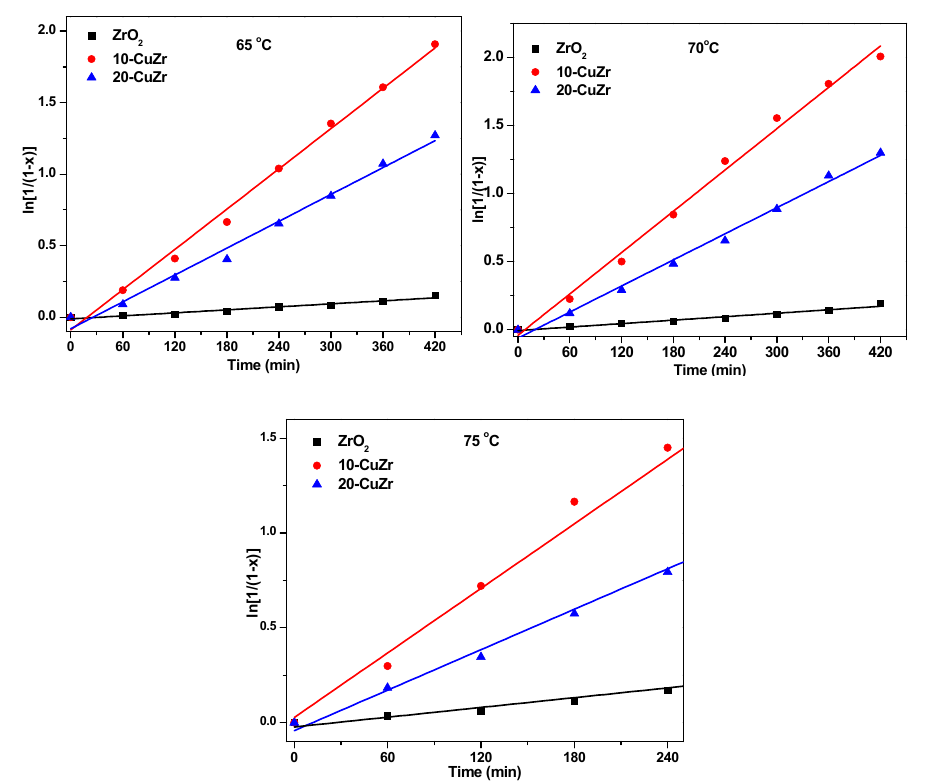
Figure 9. Plot of ln[1/(1 − x )] as a function of the reaction time for all catalysts.